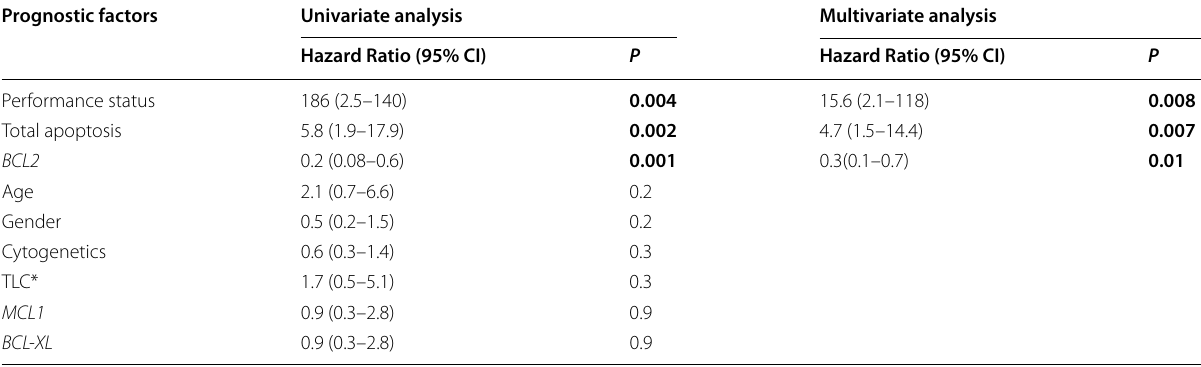
Table 4 Univariate and multivariate analyses of prognostic factors for overall survival in non‑APL patients